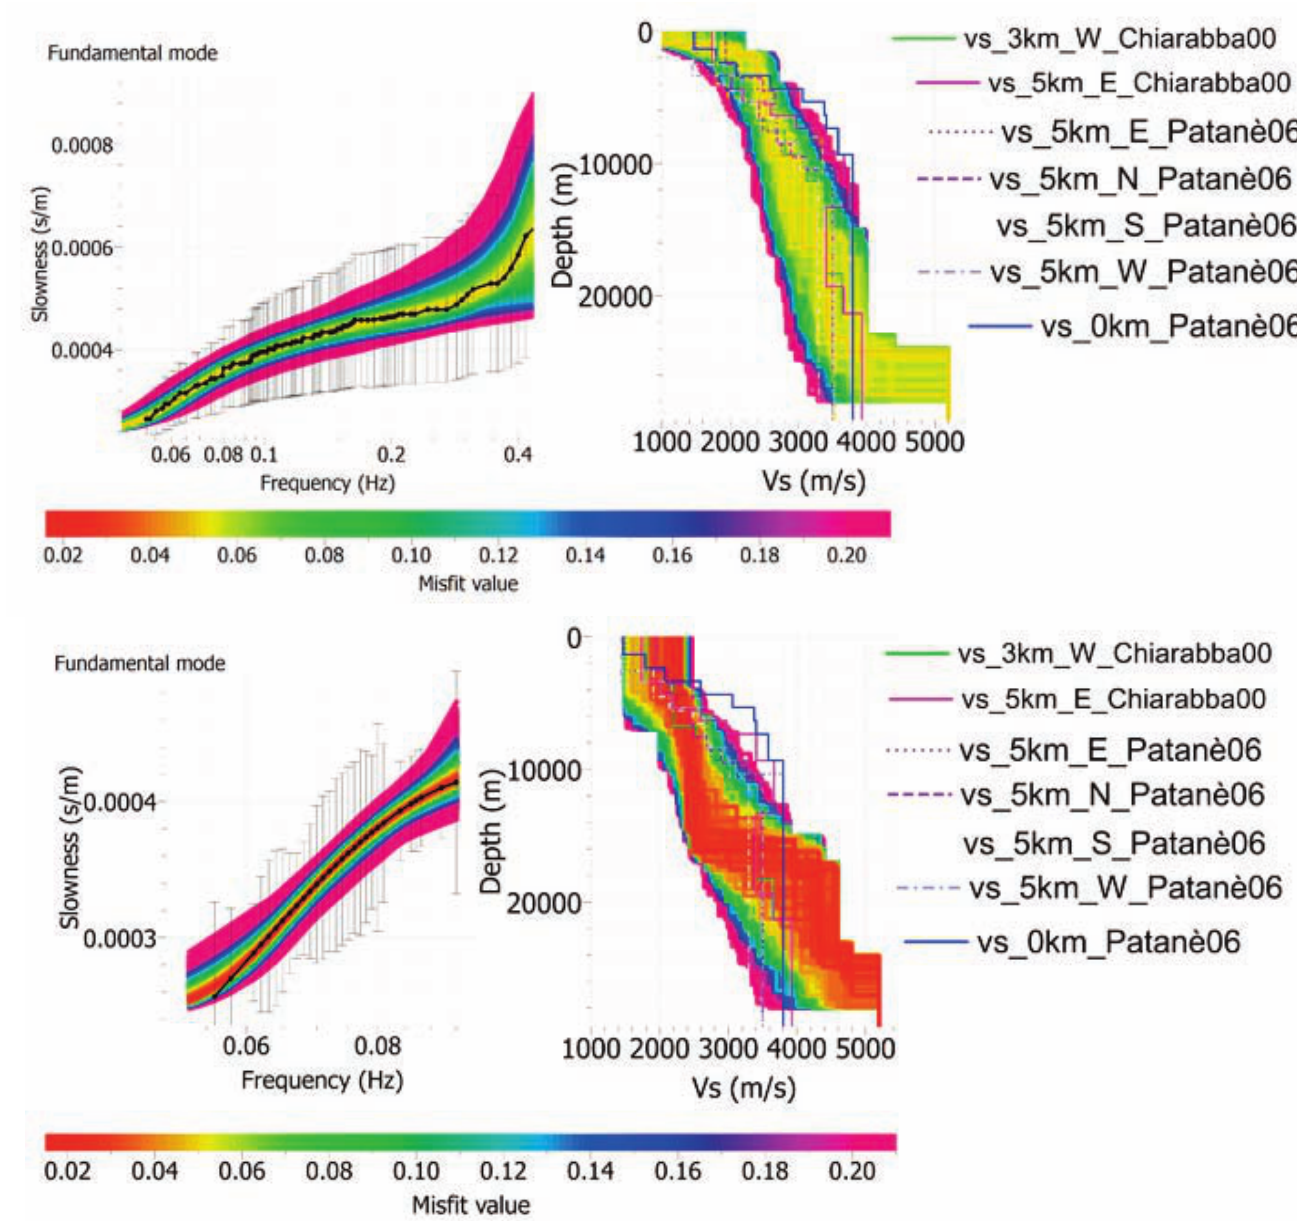
Figure 7 (top). Fits of phase-velocity dispersion curves from the p - ~ stack analysis (left) and Vs models (right) derived from the inversion procedure. The Vs models obtained are compared with the Vs profiles extracted from previous tomographic studies on Mt. Etna. Vs profile labels: vs_distance from the crater axis_direction_author of tomographic map; see text for further details. Figure 8 (bottom). Fits of phase-velocity dispersion curves from the cross-correlation method (left) and the Vs models (right). The Vs models obtained are compared with the Vs profiles extracted from previous tomographic studies on Mt. Etna. Vs profile labels as for Figure